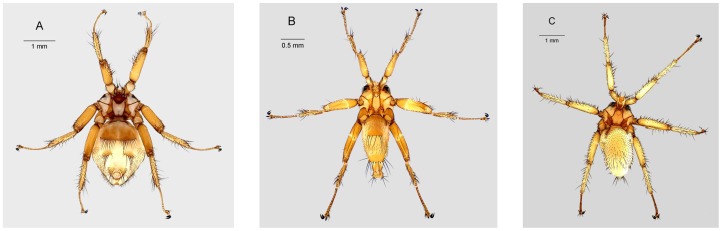
Representative genera of nycteribiid bat flies from Madagascar.A) Penicillidia leptothrinax, adult female, dorsal habitus, from Miniopterus manavi; B) Nycteribia stylidiopsis, adult female, dorsal habitus, from M. gleni; C) Eucampsipoda madagascarensis, adult female, dorsal habitus, from Rousettus madagascariensis.